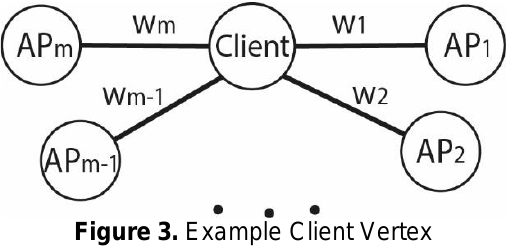
Figure 3. Example Client